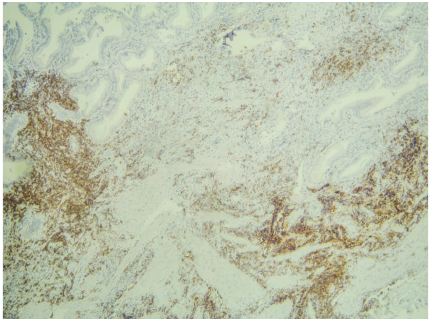
Figure 3: Immunohistochemistry ( ×40 ) showing CD5 positive small lymphocytic gallbladder